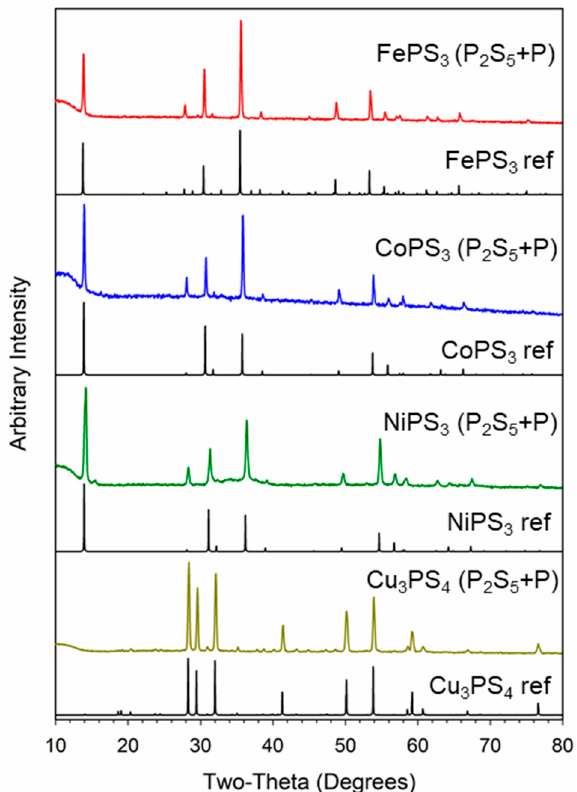
Figure 2. Powder X-ray diffraction results for MPS 3 (M = Fe, Ni, Co) and Cu 3 PS 4 products from the reaction of metal halides with molecular P 2 S 5 and elemental phosphorus at 500 °C. Reference (ref) patterns in black are shown under each reaction product.